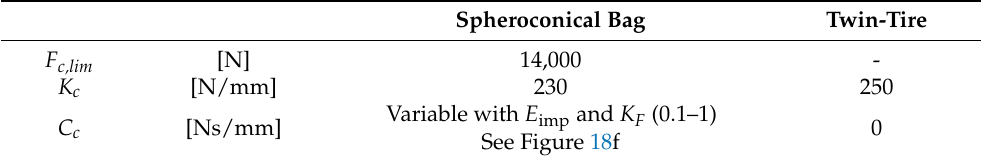
Table 5. 2-DOF input parameters for the curtain wall under SBI (with M P = 50 kg and ξ test = 12% *). Spheroconical